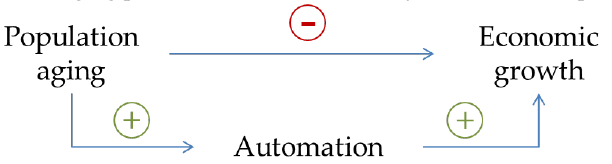
Figure 1. Diagram of relations between demographic aging and economic growth proposed by [100] Acemoglu and Restrepo